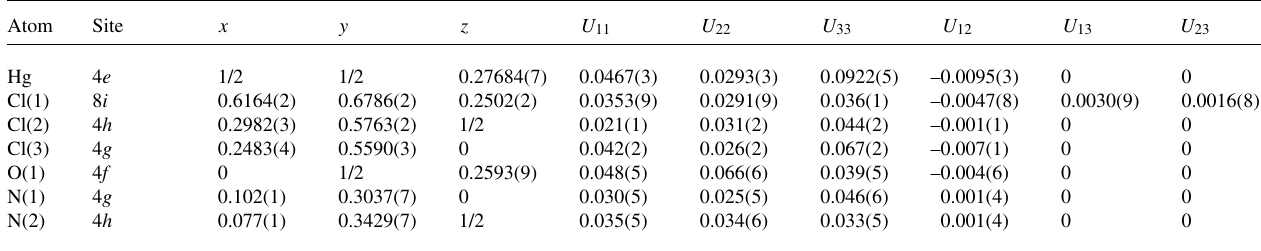
Table 3. Atomic coordinates and displacement parameters (in Å 2 )